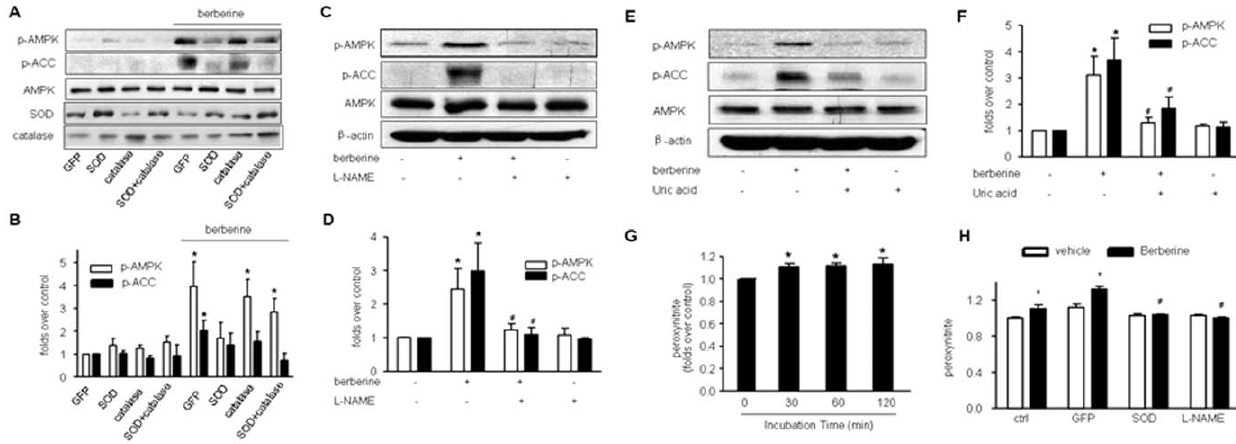
Figure 3. Activation of AMPK by Berberine is ONOO 2 -dependent. A & B , Effects of adenoviral overexpression of SOD and catalase on Berberine-induced phosphorylation of AMPK-Thr172 and ACC-Ser79 in BAEC. BAEC were transfected with adenovirus overexpressed with SOD, catalase or GFP (50 MOI) for 24 h. n=4, * p , 0.05 control versus Berberine-treated). C & D , Effects of L-NAME on Berberine-induced phosphorylation of AMPK-Thr172 and ACC-Ser79 in BAEC. BAEC were pre-treated with the eNOS inhibitor L-NAME (1 mM) for 30 min. Thereafter BAEC were treated with Berberine (10 m M) for 2 h. n=3, * p , 0.05; E & F , Effects of uric acid on Berberine-induced phosphorylation of AMPK-Thr172 and ACC-Ser79 in BAEC. BAEC were pretreated with the ONOO 2 scavenger, uric acid (0.5 mM) for 30 min, and then treated with Berberine (10 m M) for 2 h. n=4, *p , 0.05, control versus Berberine-treated, # p , 0.05, Berberine alone versus Berberine plus uric acid. G , Berberine increases the formation of ONOO 2 in BAEC. After 10 m M Berberine treatment for the time indicated and DHR (5 m M) incubation for 1 hr, the production of ONOO 2 was determined by DHR oxidation. n=4 * p , 0.05 control versus Berberine-treated. G . Effects of adenoviral overexpression of SOD or L-NAME on the formation of ONOO 2 caused by berberine in BAEC. After Berberine (10 m M) treatment for the time indicated and DHR (5 m M) incubation for 1 hour, the production of ONOO 2 was determined by DHR oxidation. n=4 * p , 0.05 control versus Berberine-treated.